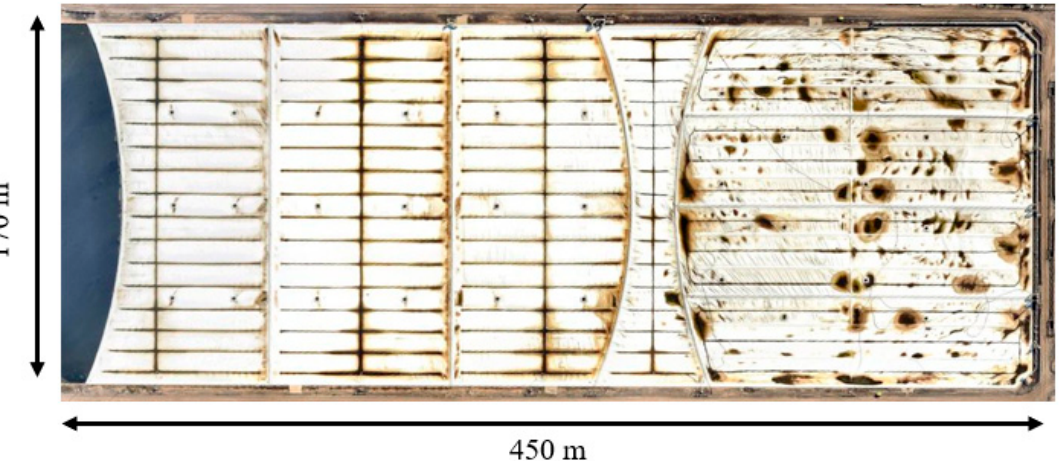
Figure 1. Floating high-density polyethylene (HDPE) membrane cover at the Western Treatment Plant (WTP) anaerobic wastewater lagoons in Melbourne, Australia.